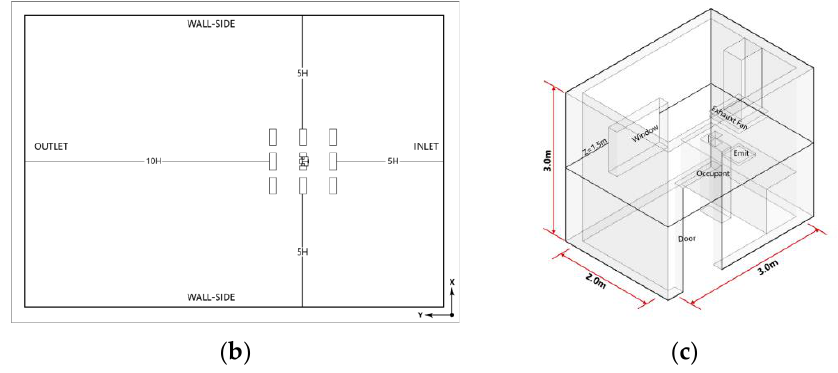
Figure 4. Build physical models: ( a ) the building model; ( b ) calculation range of fluid domain; ( c ) kitchen space layout and section selection.